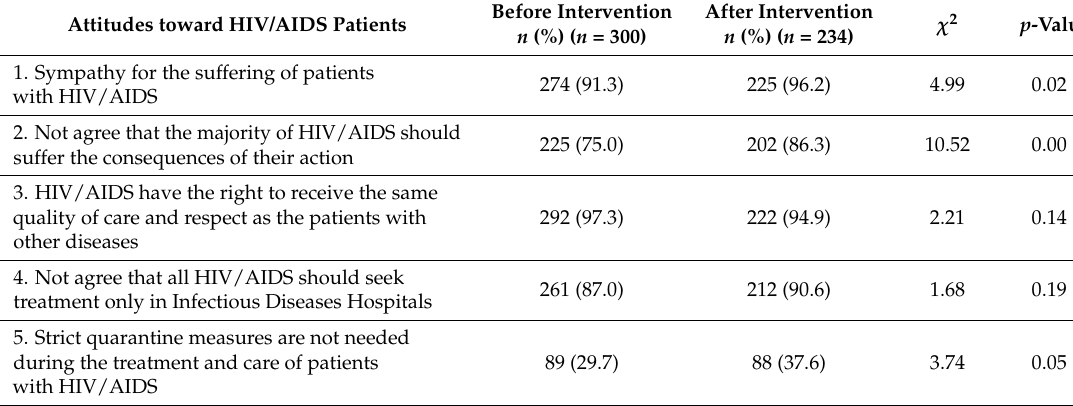
Table 8. Changes in responses to attitudinal questions toward HIV/AIDS patients after intervention. Attitudes toward HIV/AIDS